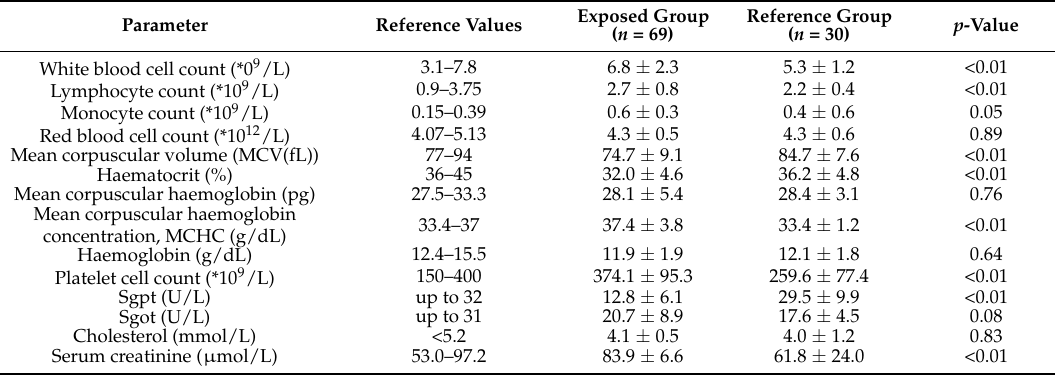
Table 3. Hematological and biochemical comparisons between the exposed and reference groups. Results are given as mean and standard deviation (SD).